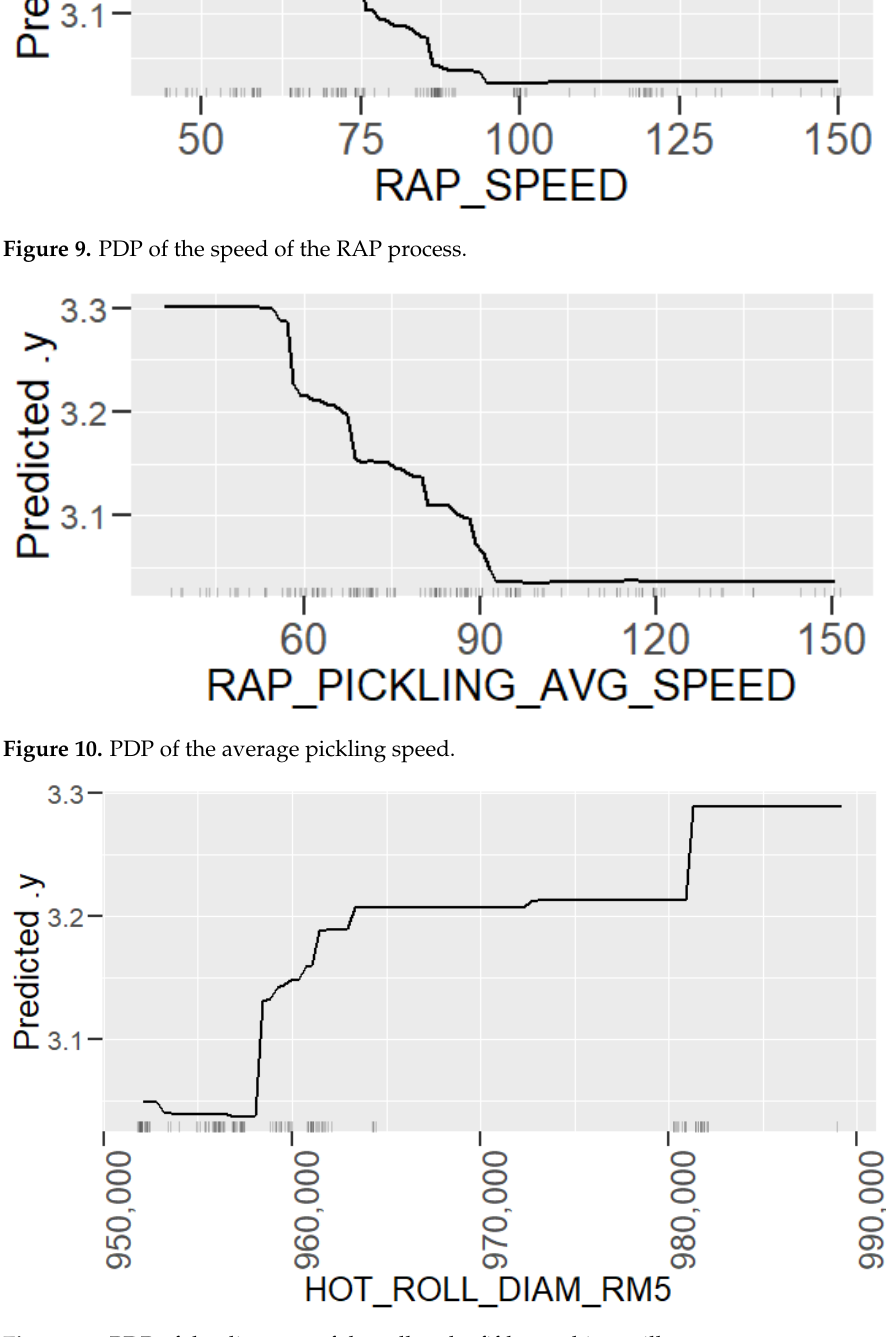
Figure 11. PDP of the diameter of the roll at the fifth roughing mill